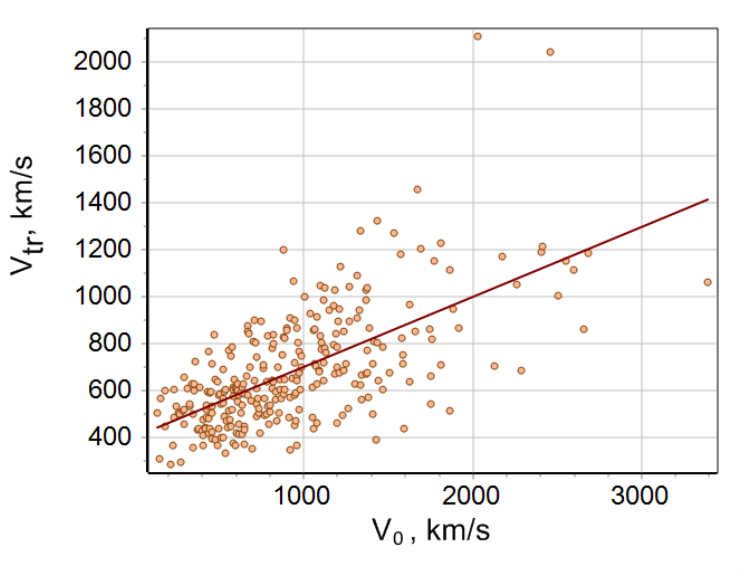
Figure 2. The relation of the initial CME speed ( V 0 ) and the transit speed of the corresponding ICME ( V tr ) for 288